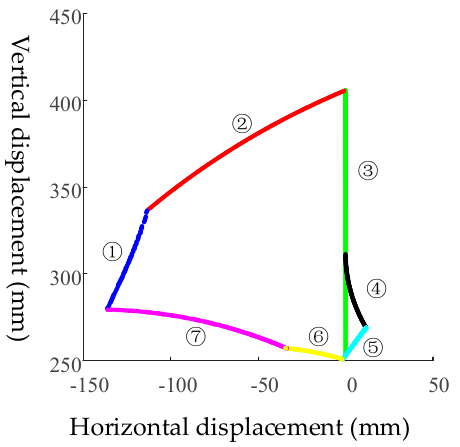
Figure 5. Trajectory boundary of point F at the end of the mechanism.